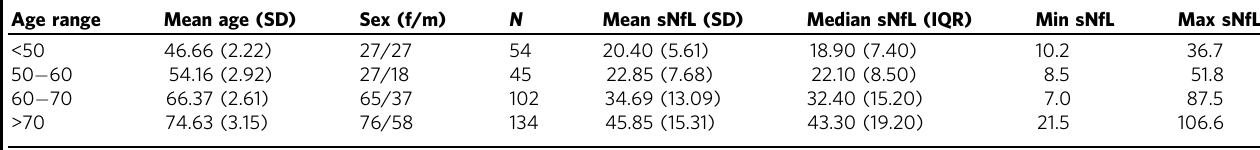
Table 2 Descriptive statistics of sNfL (pg mL − 1 ) levels in examined population per age groups.